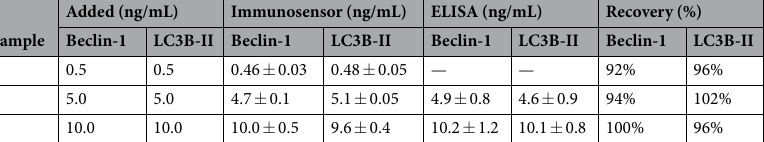
Table 1. Comparison of the assay results for spiked samples by using the proposed immunosensor and the referenced ELISA method. (n = 5). a The symbol“–”suggest that the sample could not be detected by the corresponding